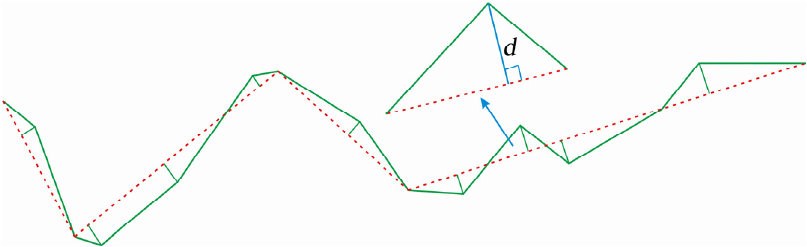
Figure 4. The average offset distance of a polyline.